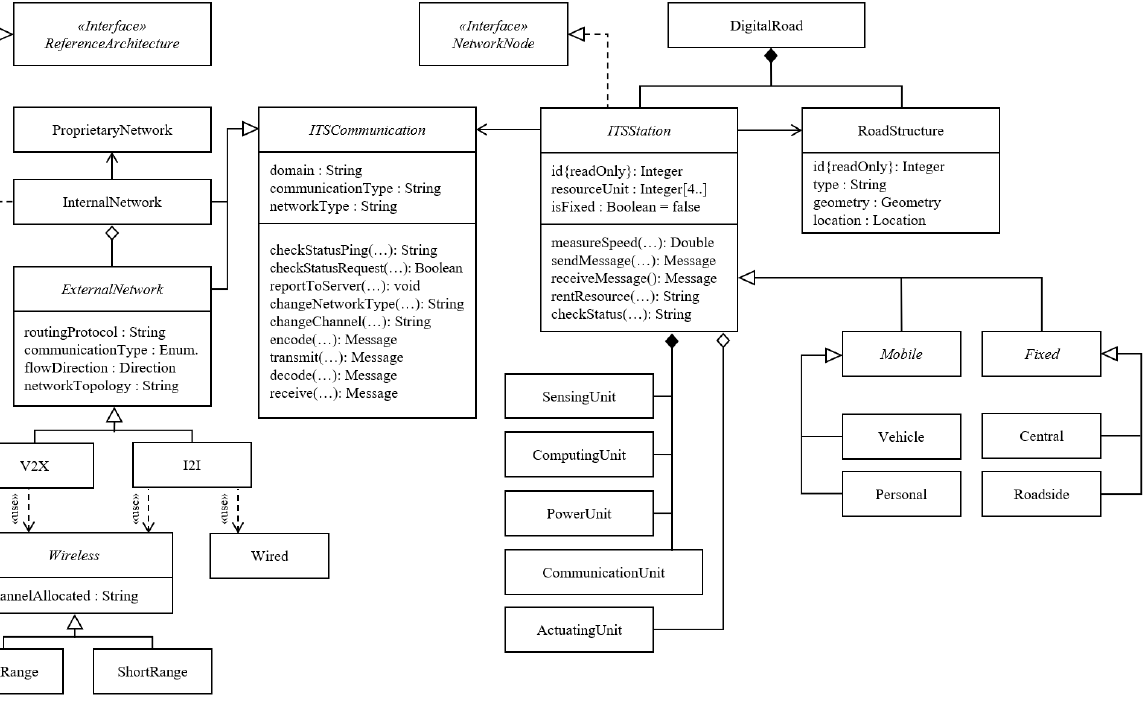
Figure 4. The semantic model for ITS for